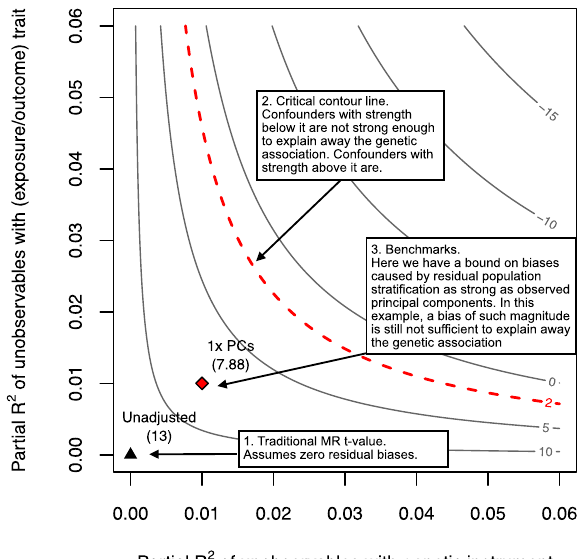
Fig. 2 Sensitivity contour plot with benchmark bounds. The horizontal axis shows the partial R 2 of unobserved variables W with the genetic instrument; this corresponds to the percentage of residual variation of the genetic instrument explained by W . The vertical axis shows the partial R 2 of W with the trait of interest, which can be either the exposure trait or the outcome trait; again, this stands for the percentage of residual phenotypic variance explained by W . Given any pair of partial R 2 values, the contour lines show the t-value that one would have obtained for testing the signi fi cance of the genetic association with the (exposure/outcome) trait, had a W with such strengths been included in the analysis. The point represented by a black triangle (left lower corner) shows the t -value of a traditional MR study (i.e., t = 13) — note it assumes exactly zero biases due to unobserved variables W . As we move along both axes, the biases due to W get worse, and can eventually be strong enough to reduce the t -value below a chosen critical level t * , shown in the red dashed line (e.g., t * ≈ 2 for a signi fi cance level of α = 5%). Unobserved variables W with strength below the critical red line are not strong enough to change the conclusions of the original MR study; on the other hand, unobserved variables W with strength above the critical red line are strong enough to be problematic. The point represented by a red diamond bounds the maximum strength of W if it were as strong as observed genomic principal components (1× PCs). They show the maximum bias caused by residual population strati fi cation, if it had the same explanatory power as the PCs in explaining genetic and phenotypic variation. In this example, the plot reveals that residual population strati fi cation as strong as the fi rst genomic principal components would not be suf fi cient to make the genetic association statistically insigni fi cant (i.e., the adjusted t-value accounting for a W with such strength is 7.88, which is still above the critical threshold of t * ≈ 2). Finally, we note that if the unobserved variable W is a singleton, then all the sensitivity analysis results are exact. If W consists of multiple variables, then all sensitivity analysis results are conservative, meaning that this is the worst bias that a multivariate W could cause if it had such strengths 46